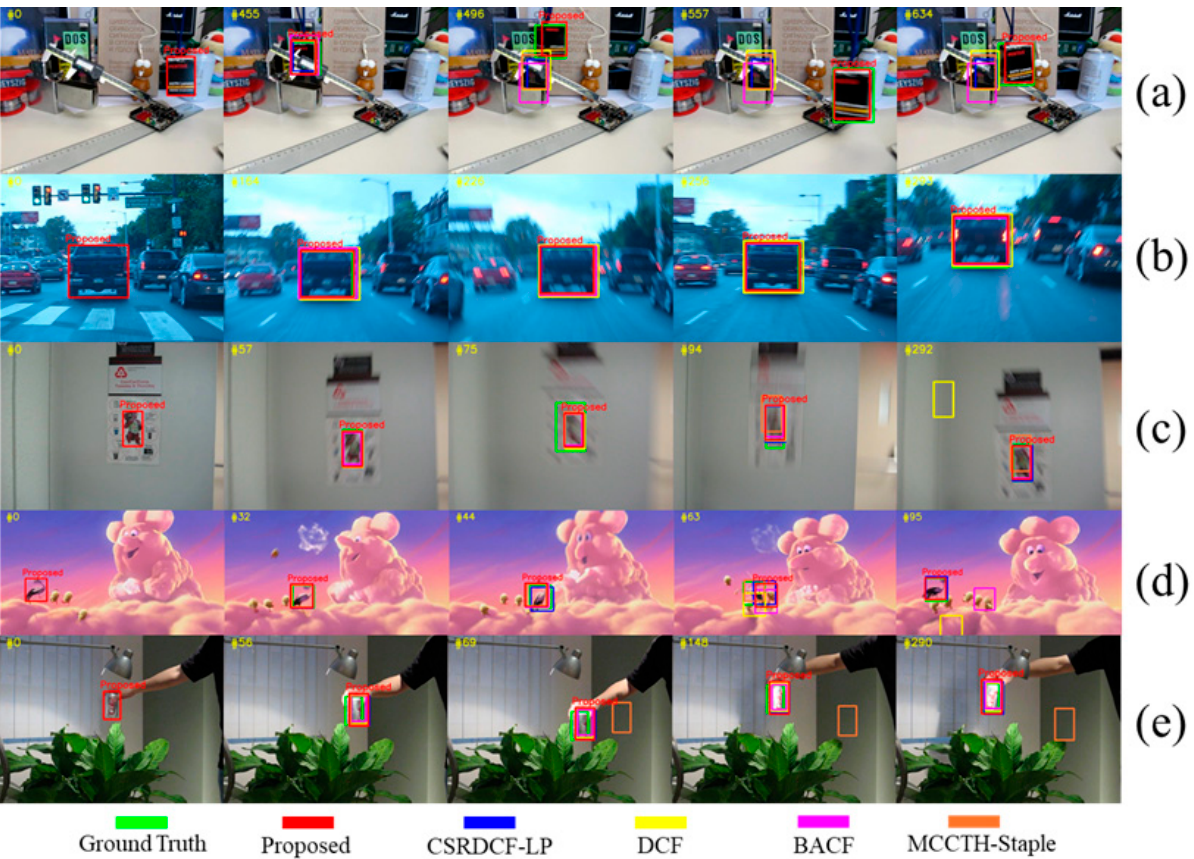
Figure 17. Tracking Results of Various Tracking Sequences. ( a ) Box Tracking Result, ( b ) BlurCar4 Tracking Result, ( c ) BlurOwl Tracking Result, ( d ) Bird2 Tracking Result, ( e ) Coke Tracking Result.